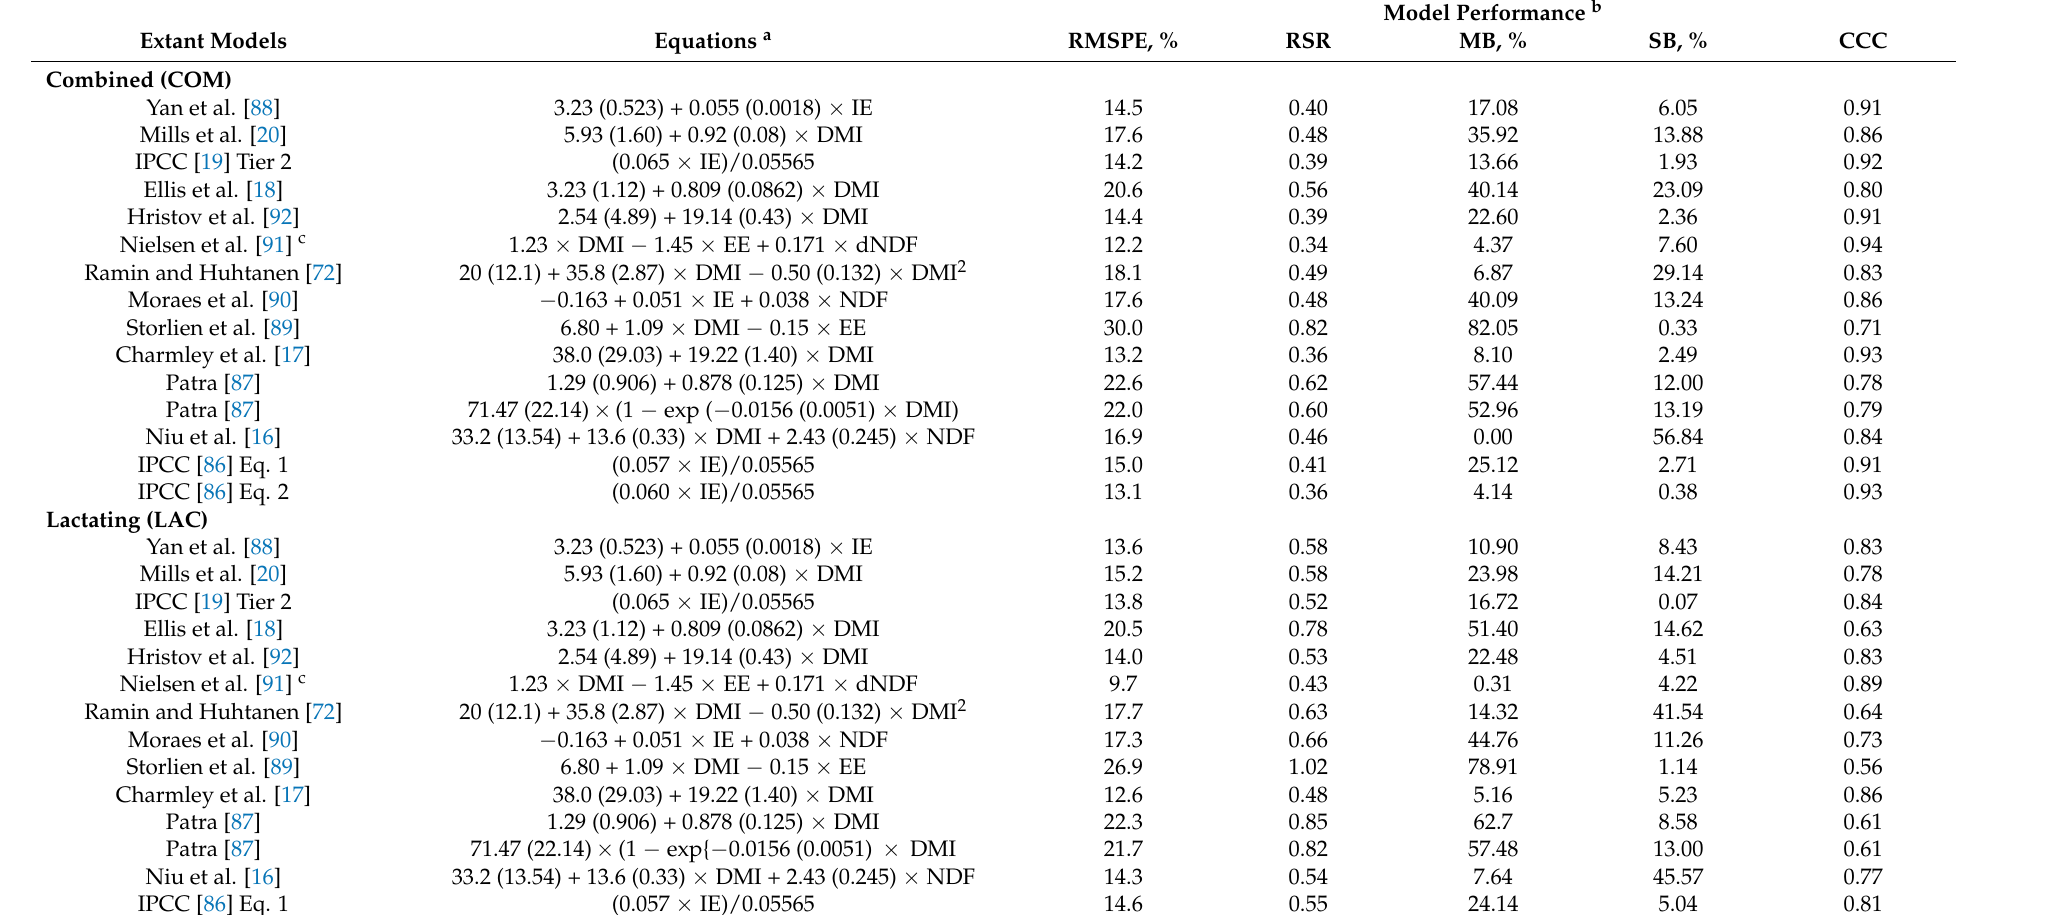
Table 4. Published methane production (g/d) equations evaluation using combined (COM; n = 61) and lactating cows (LAC; n = 48)